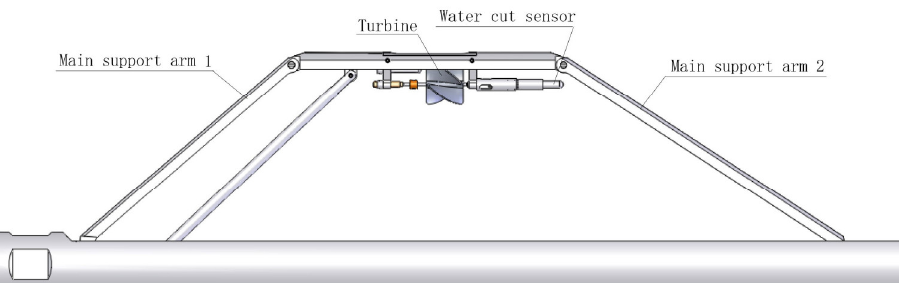
Figure 2. Schematic diagram of single-probe multi-position measurement fluid imager (SPFI).